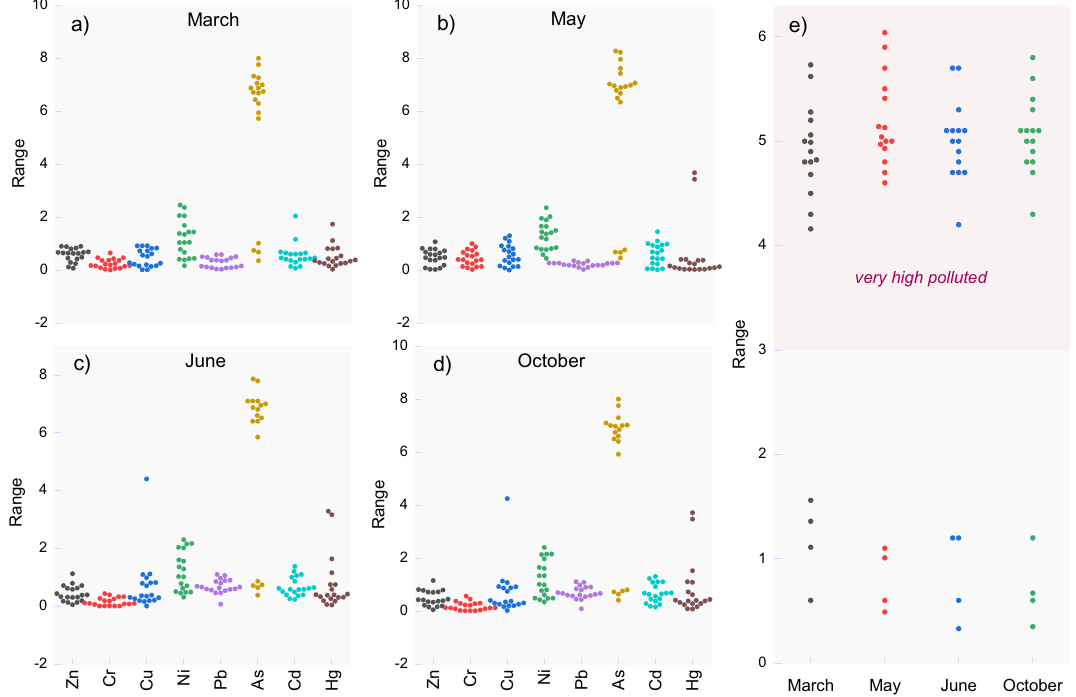
Figure 5. Contamination factor (CF) calculated for ( a ) March, ( b ) May, ( c ) June, ( d ) October, and Pollution Load Index (PLI) values ( e ) in the surface sediments of the Olt River graphical